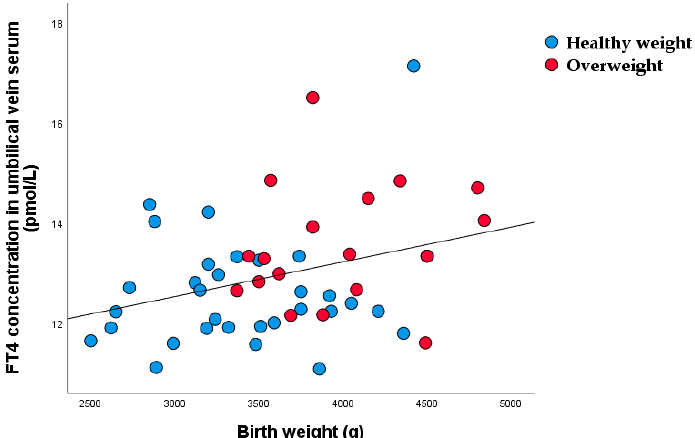
Figure 9. Linear regression between birth weight and FT4 in umbilical vein serum (r = 0.320, p = 0.024).